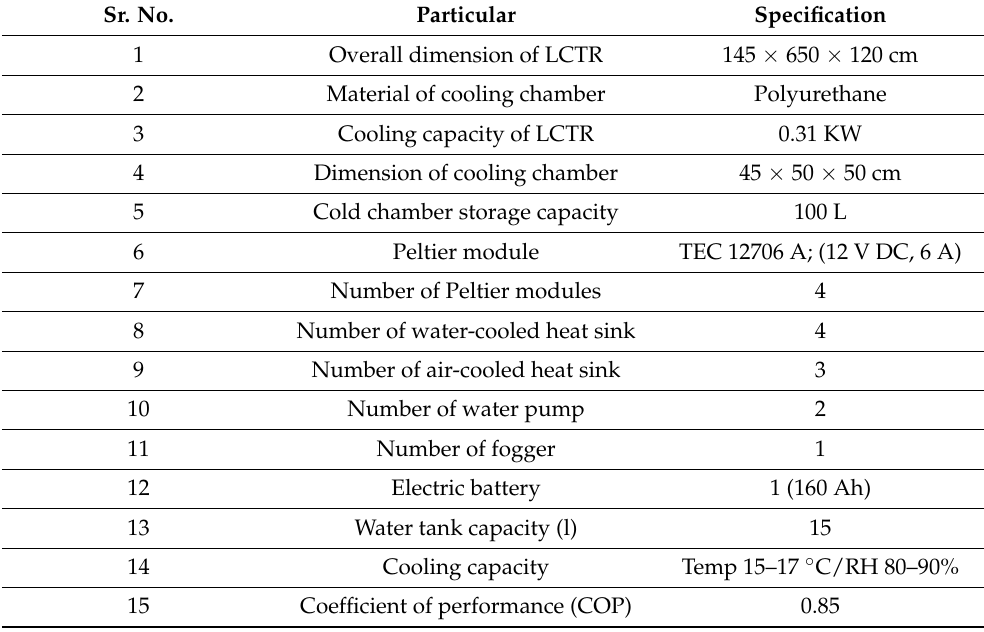
Table 1. Specifications of the liquid-cooled thermoelectric refrigeration system.